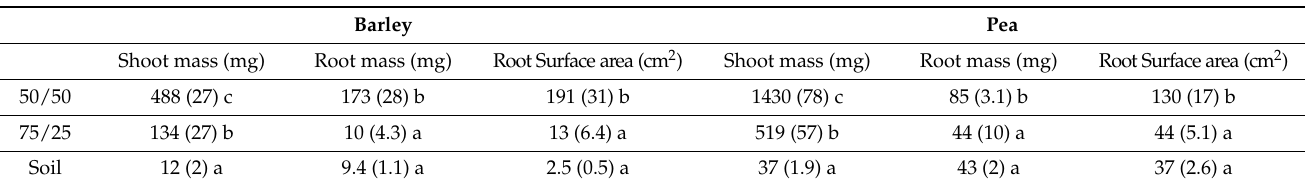
Table 3. Barley and pea growth parameters as measured in the rhizobox experiment. Values are means of triplicate rhizoboxes (+/ − S.E.M). Values with different letter beside them indicate significant statistical differences within columns.